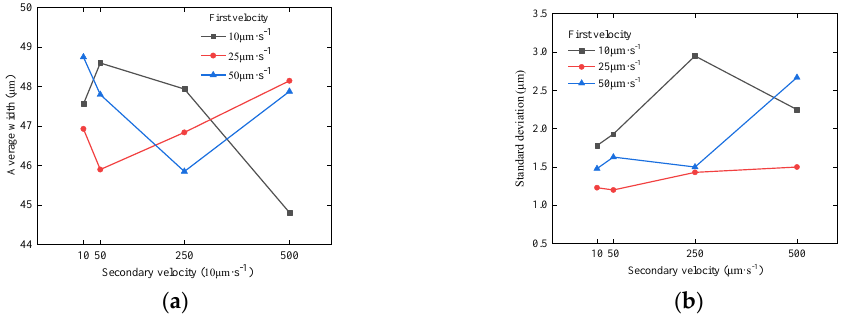
Figure 8. Summary of measurement result: ( a ) average slit width; ( b ) standard deviation.